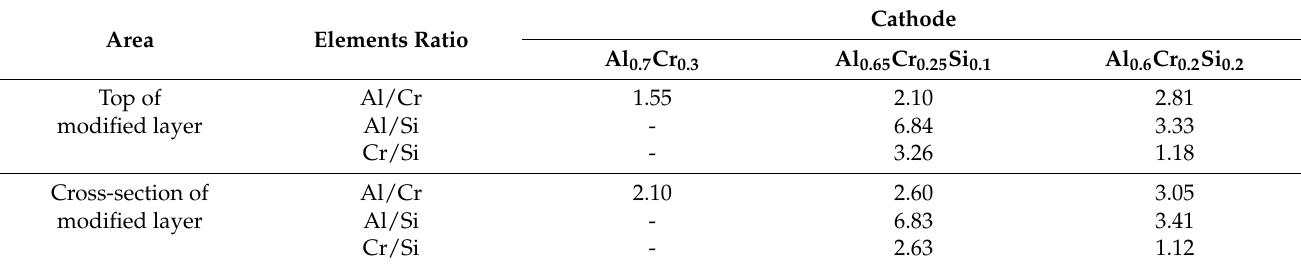
Figure 7. Elemental analysis of the modified layer of the cathodes: ( a , d ) Al 0.7 Cr 0.3 ; ( b , e ) Al 0.65 Cr 0.25 Si 0.1 ; ( c , f ) Al 0.6 Cr 0.2 Si 0.2 . ( a – c )—top view; ( d – f )—cross section. Investigated ar- eas are marked with numbers. Table 3. Elements ratio in the top and cross section parts of the modified